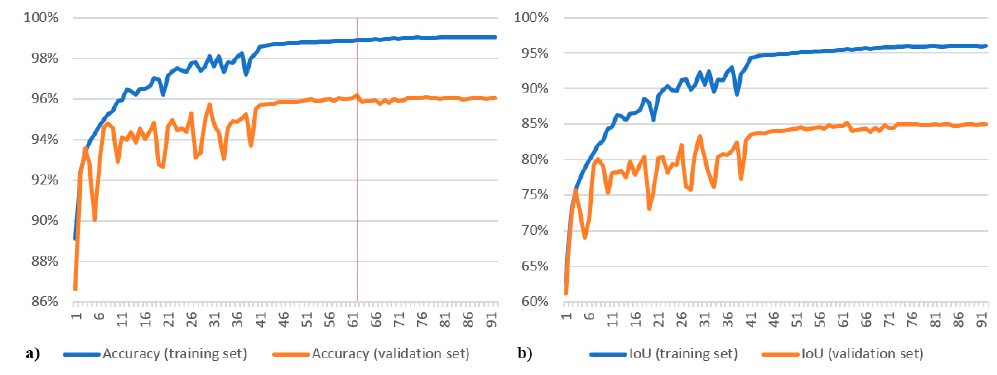
Figure 12. Accuracy ( a ) and IoU ( b ) metrics for the PSPNet model.